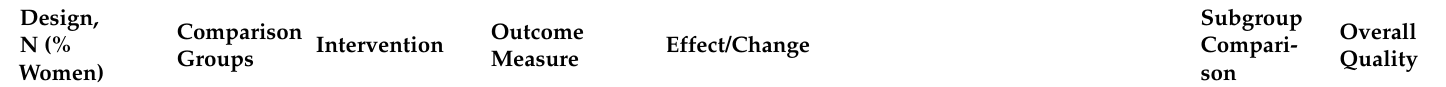
Anxiety and depression decreased from before to and sleep after the intervention, and sleep quality quality